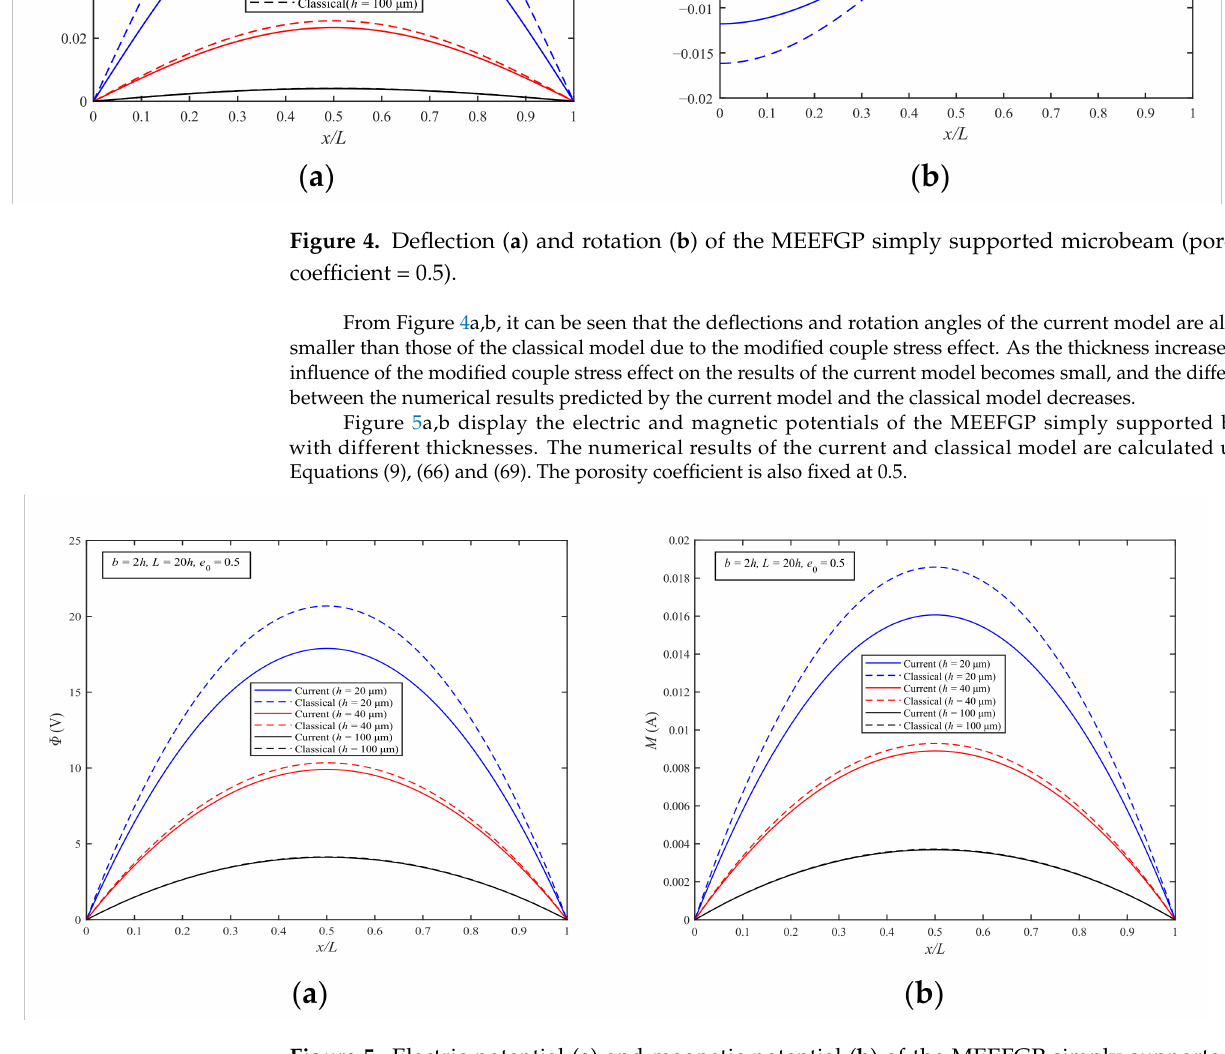
Figure 5. Electric potential ( a ) and magnetic potential ( b ) of the MEEFGP simply supported mi- crobeam (porosity coefficient =